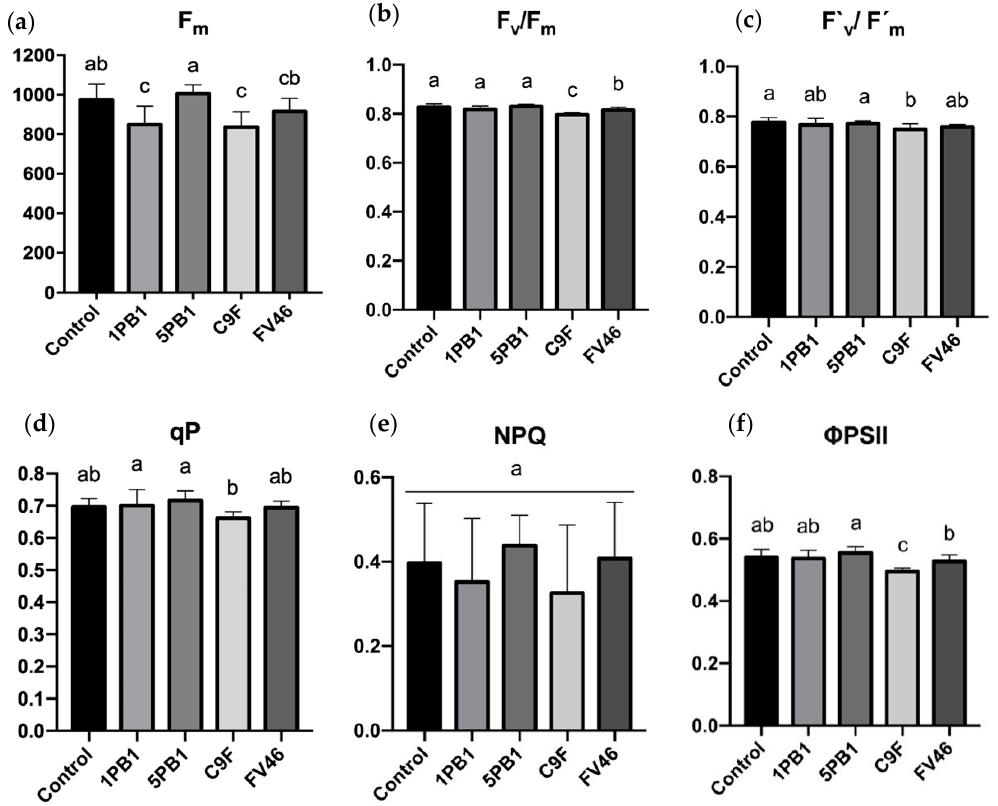
Figure 3. Effects of inoculation with isolates 1PB1, 5PB1, C9F and FV46 on PSII chlorophyll fluorescence of 130-day-old plants. Measurements on each treatment group were preformed (n = 8). Means with the same letter are not significantly different according to the Dunnett test ( p < 0.05).